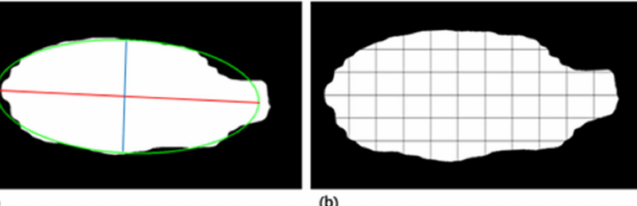
Figure 11. Calculating weight features: ( a ) optimal ellipse of the segmentation mask; ( b ) grid lengths.